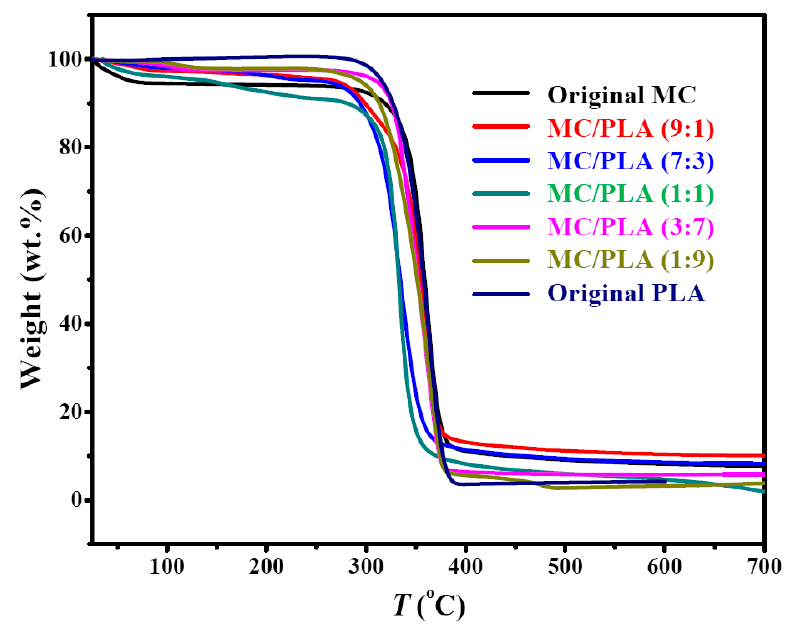
Figure 6. TGA curves of original MC, MC/PLA membranes, and original PLA.